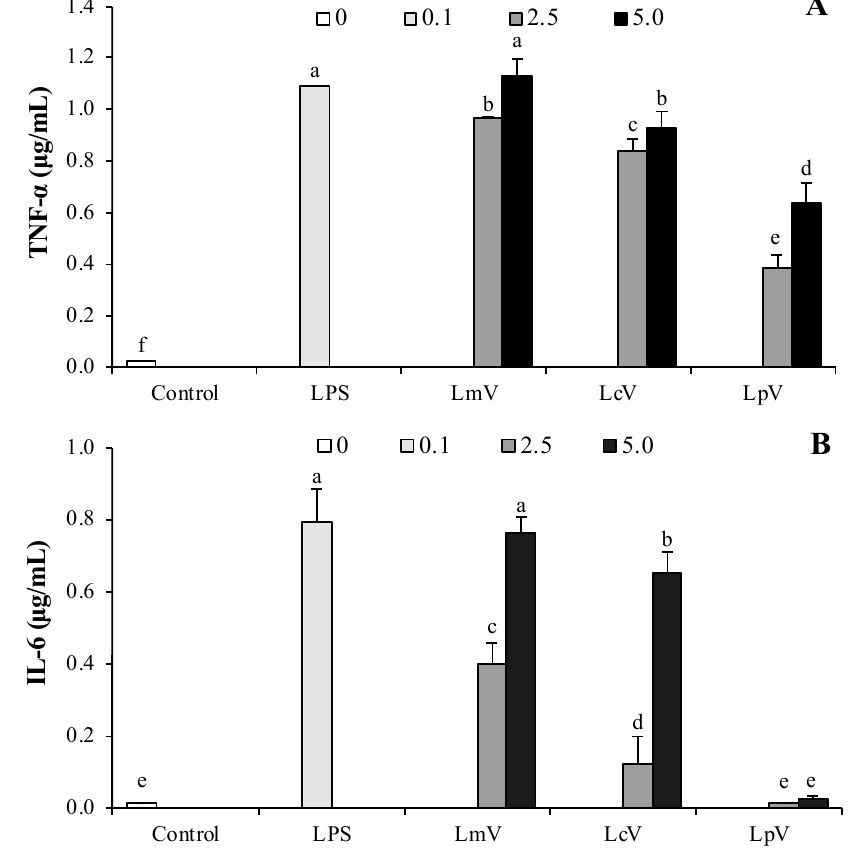
Figure 2. Stimulatory effect of Le. mesenteroides , Ll. curvatus, or Lp. plantarum -derived ECVs (LmV, LcV, or LpV) on the production of ( A ) TNF- α and ( B ) IL-6 in RAW264.7 macrophages. LPS (0.1 µ g/mL) was used as a positive control. Values are expressed as the mean ± SD ( n = 4) and those followed by different letters (a–f) within a property are significantly different ( p < 0.05) according to Duncan’s multiple range